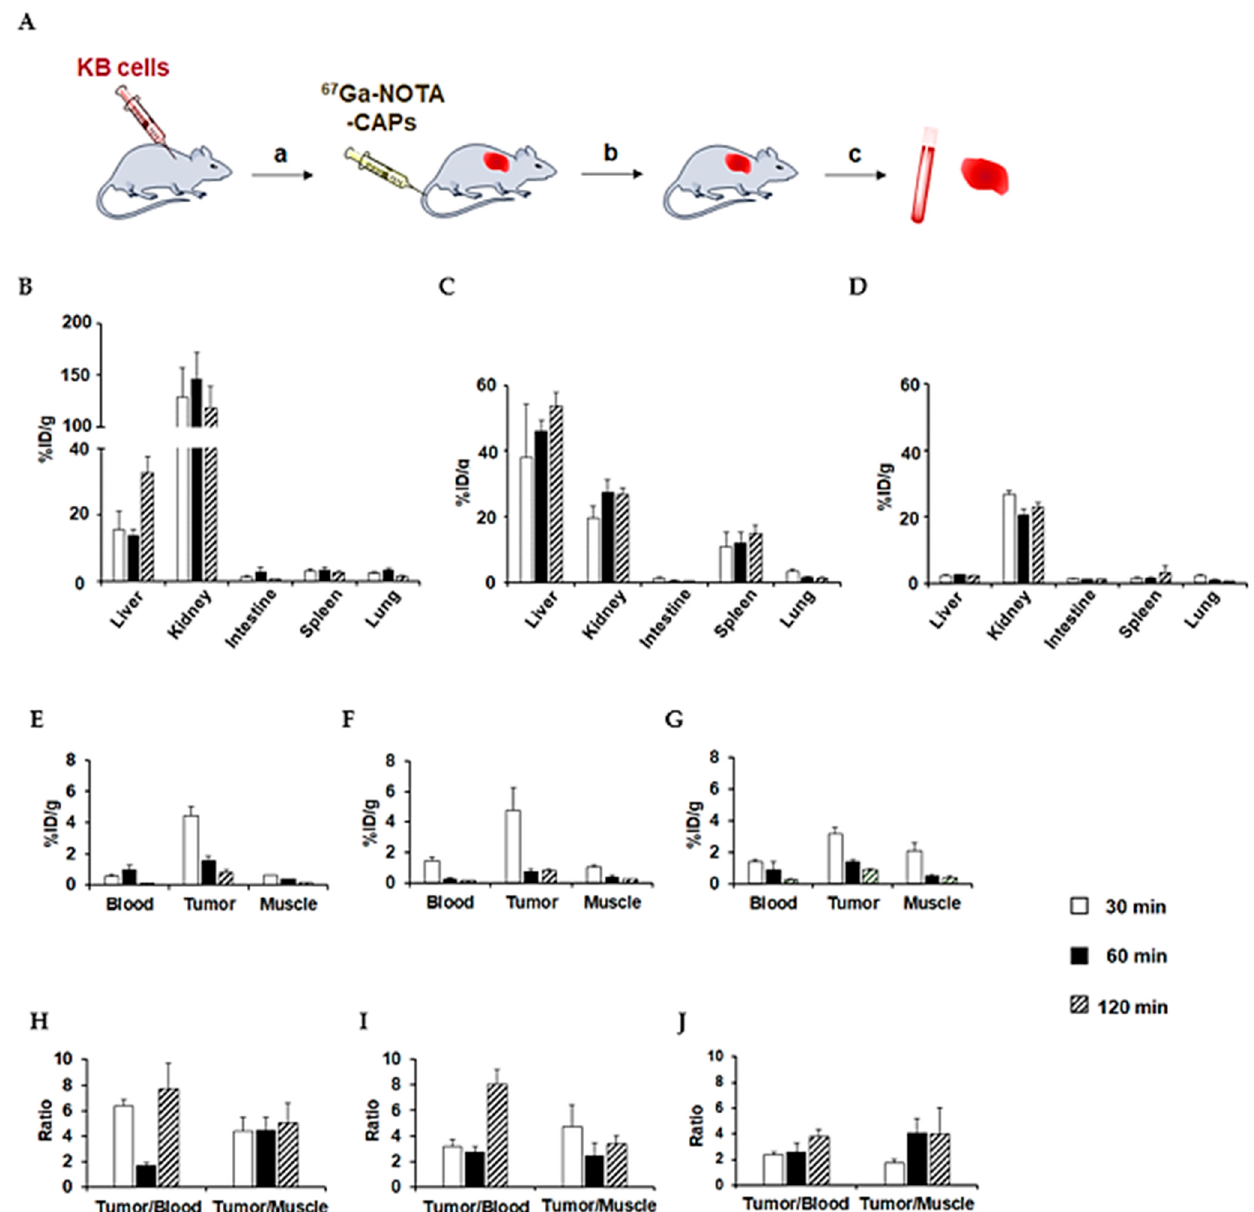
Figure 8. Schematic of the experimental design of the in vivo experiments ( A ): BALB/c nu/nu mice were subcutaneously injected with 1.0 × 10 7 KB cells ( a ). Tumors were allowed to reach 300–500 mm 3 (1-2 weeks after inoculation) prior to conducting bio-distribution studies ( b ). 67 Ga-NOTA-CAPs (10 kBq/100 µ L) were intravenously injected via the tail vein ( c ). Mice were sacrificed at each time point, and then blood samples were taken and organs were dissected. Tissues were then weighed and radioactivity was measured by automated gamma counting. In vivo biodistribution of 67 Ga-NOTA-KV6 ( B , E ), 67 Ga-NOTA-RV6 ( C , F ), and 67 Ga-NOTA-HV6 ( D , G ) over time in KB tumor-bearing mice. Data are expressed as percent injected dose per gram of tissue (%ID/g). Each value represents the mean (standard deviation) of 4–6 mice. Tumor-to-blood and tumor-to-muscle ratios for 67 Ga-NOTA-KV6 ( H ), 67 Ga-NOTA-RV6 ( I ), and 67 Ga-NOTA-HV6 ( J ) were calculated at different time points.